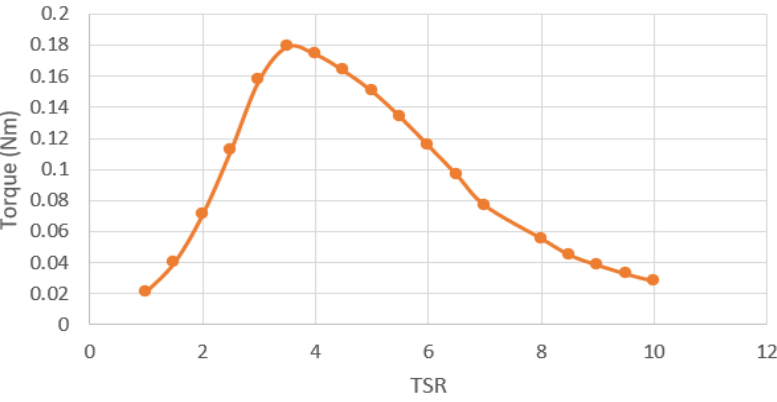
Figure 6. Torque vs. tip speed ratio (TSR) for 3 blades of VAWT.